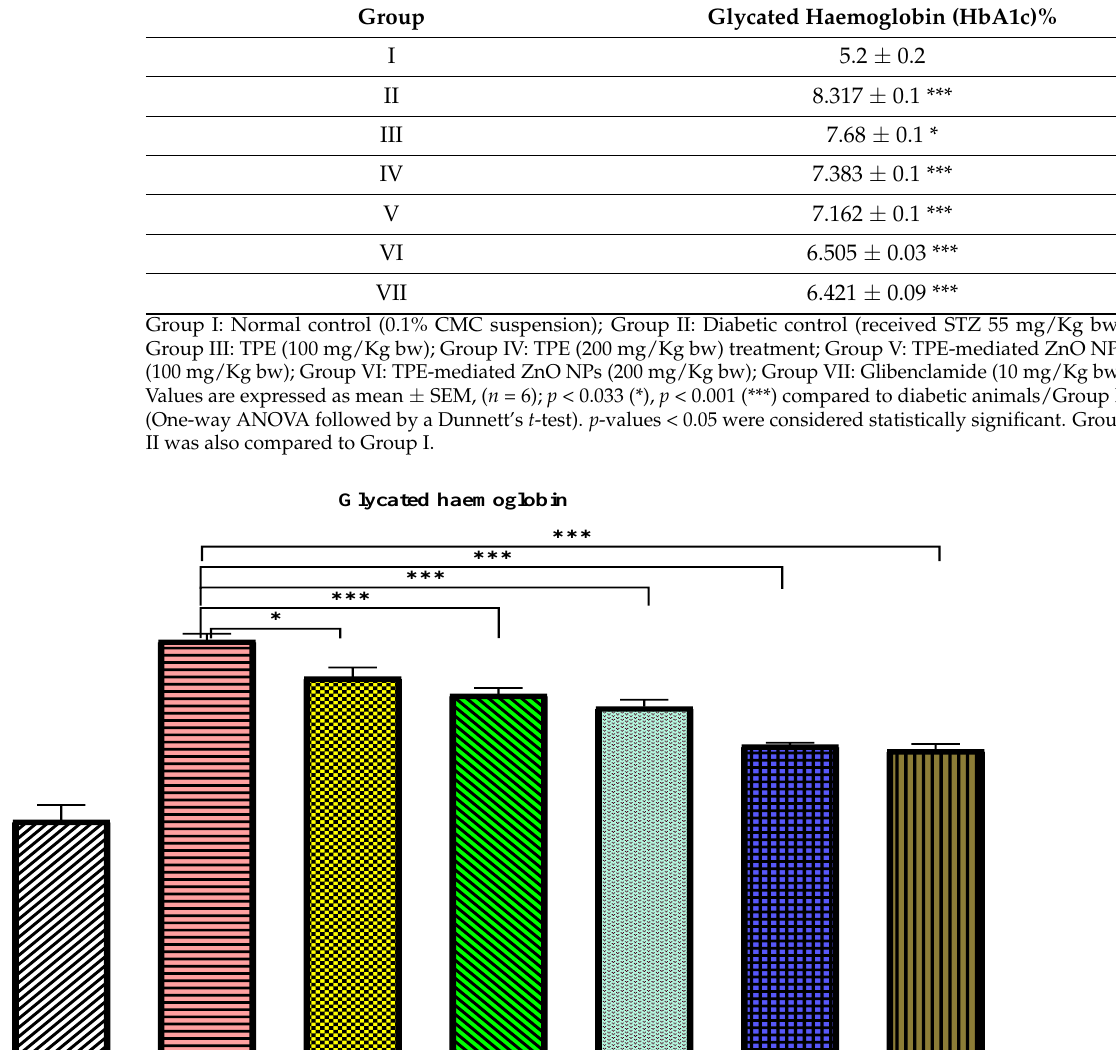
Table 6. In STZ-induced diabetic rats, the effects of TPE, TPZnO NPs, and glibenclamide on glycated hemoglobin.